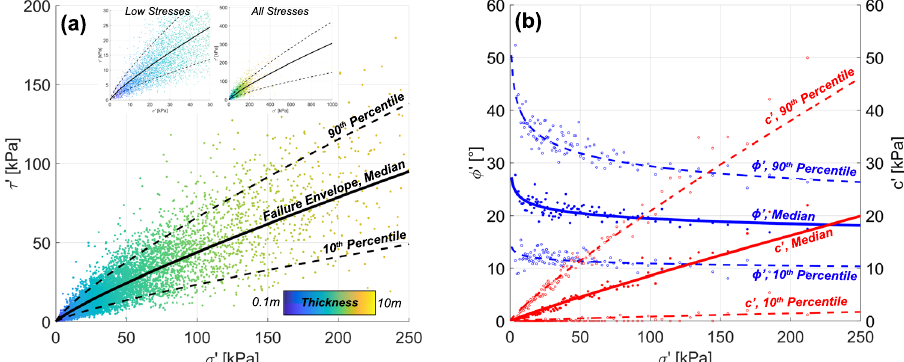
Fig. 2 | Landslide shear strength (m=0.5 conditions) and associated stresses based on mean landslide thicknesses (n=7330 landslides). a Effective normal stress ( σ ‘ ) versus shear stress ( τ ‘ ) for landslide inventories colored by mean land- slide thickness. Black lines represent moving median and 10 and 90% quantiles. Power-law fi ts to the moving quantiles for a 1% moving window to represent plausible landslide failure envelopes (median envelope: τ ˊ =0.913 σ ˊ 0.841 , R 2 =0.969,